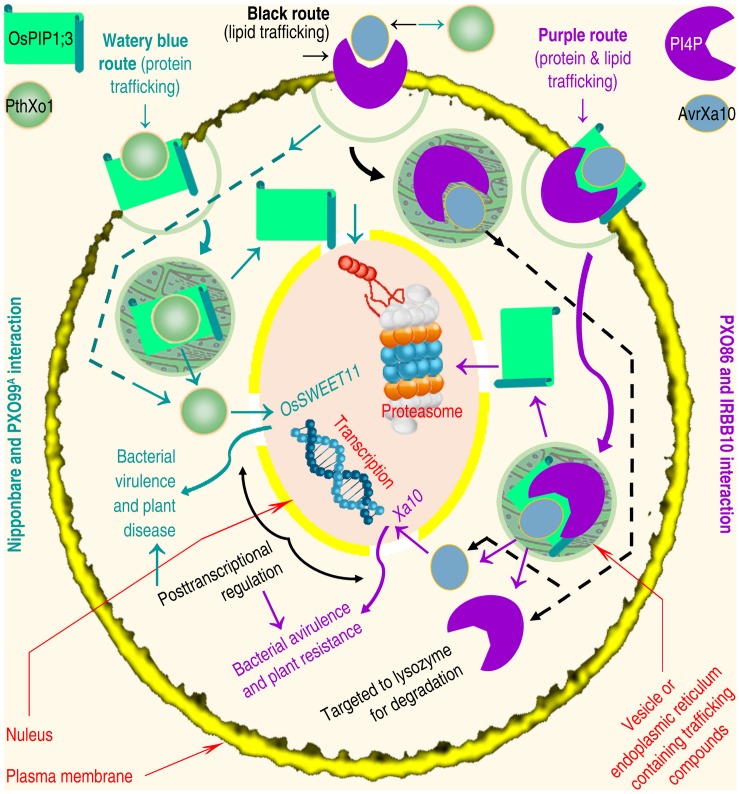
Diagram of hypothesized PM protein and lipid trafficking that is going through ER (Obacz et al., 2017) or vesicles (Wudick et al., 2015) and drives T3 effector endocytosis (Domingues et al., 2016). The OsPIP1;3-dependent and/or PI4P-involved PthXo1 and AvrXa10 translocation is used as a study paradigm. The protein and lipid trafficking pathways are annotated as a motivation for both effectors to be internalized and then both effectors execute the transcriptional regulation on their target genes. Both pathways may involve unannotated response, that is the recognition of Hpa1 by OsPIP1;3 and HrpF by PI4P (Büttner et al., 2002, Büttner, 2012; Ji and Dong, 2015b). The protein and lipid trafficking may be concurrent, cooperative or independent, making responses on PMs more intricate than the regular remodeling in the absence of bacterial proteins (Hubber and Roy, 2010; Piscatelli et al., 2016; Santi-Rocca and Blanchard, 2017).